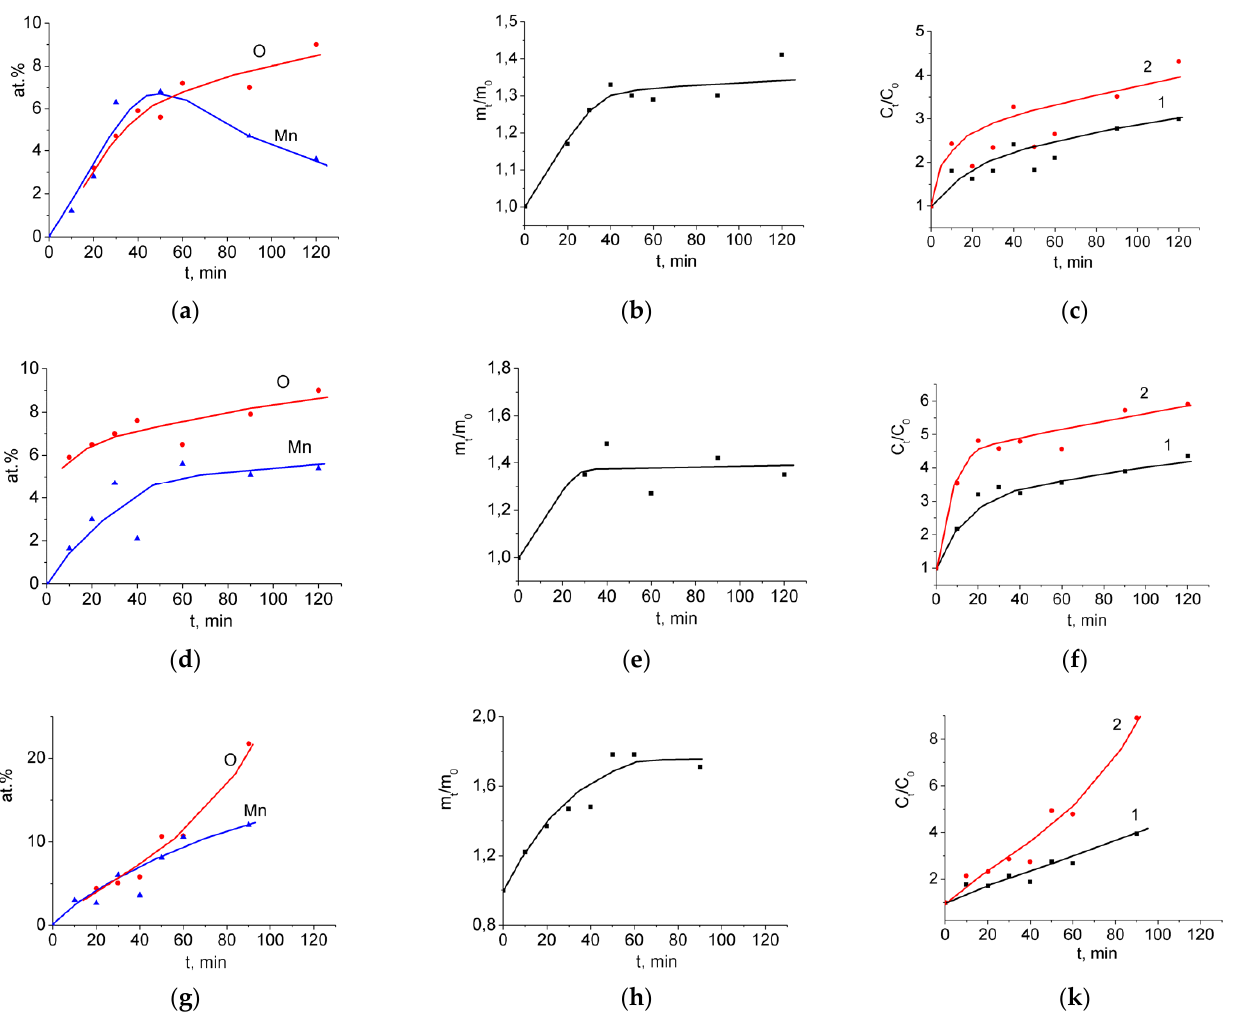
Figure 4. ( a,d,g ) Concentrations of Mn and O, at.%; ( b,e,h ) weight increase, m t /m 0 ; ( c,f,k ) increase in the specific capacitance, C t /C 0 1: C spm , 2: C sps . Concentration of the KMnO 4 solution: ( a – c ) 0.2 wt.%;